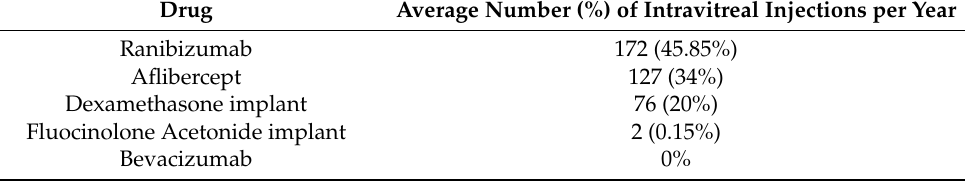
Table 1. Intravitreal agents used in the treatment of diabetic macular edema